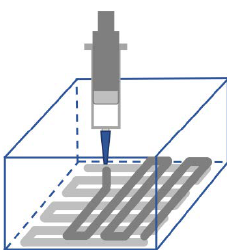
Figure 4. Schematic representation of the robocasting fabrication process. The ceramic scaffold is built layer-by-layer from a CAD model. The three-axis robotic arm moves the injection syringe while expressing the ceramic ink through the conical deposition nozzle to create the desired structure immersed in an oil